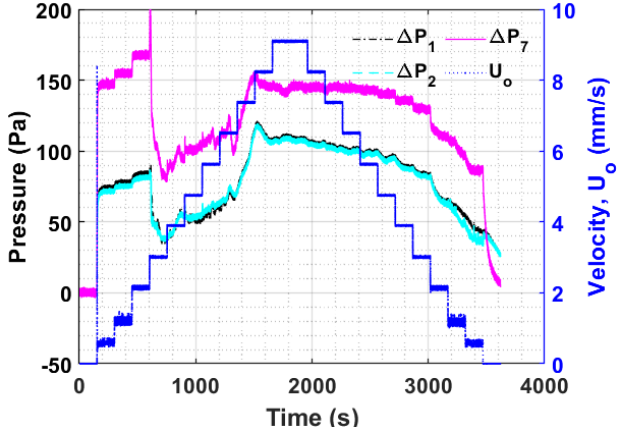
Figure 6. Velocity, overall pressure drop ( Δ P 7 ), and upper region transients (i.e., Δ P 1 and Δ P 2 ) for the fluidization and defluidization cycles.